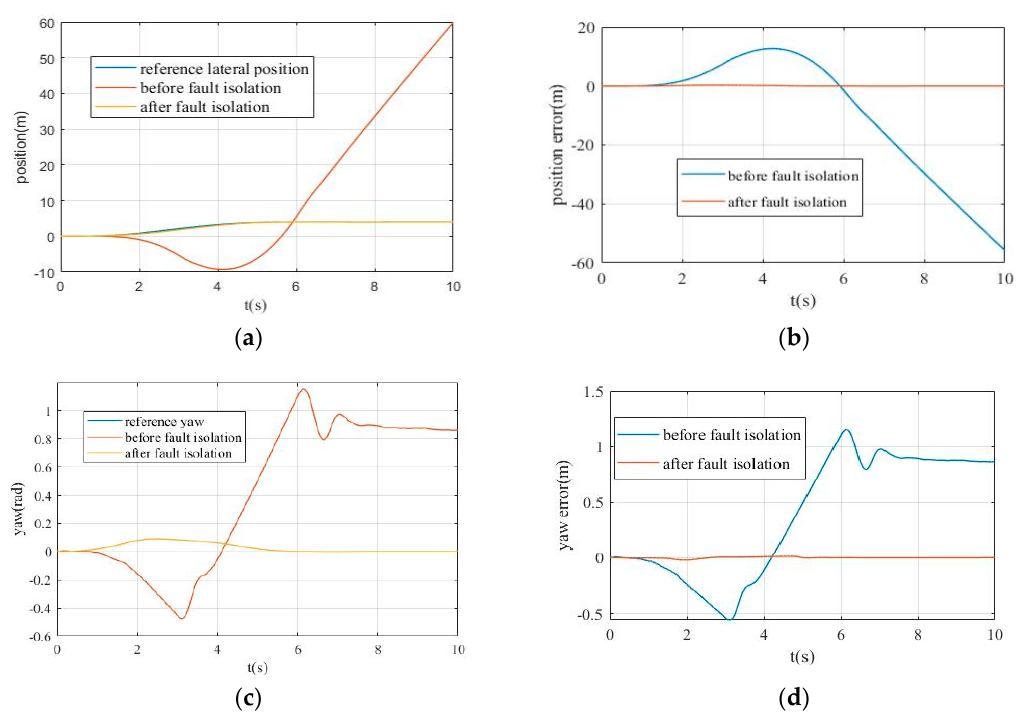
Figure 12. The path tracking control simulation results: ( a ) the lateral position changes; ( b ) the lateral position error before and after fault isolation; ( c ) the yaw angle changes; ( d ) the yaw angle error before and after fault isolation.